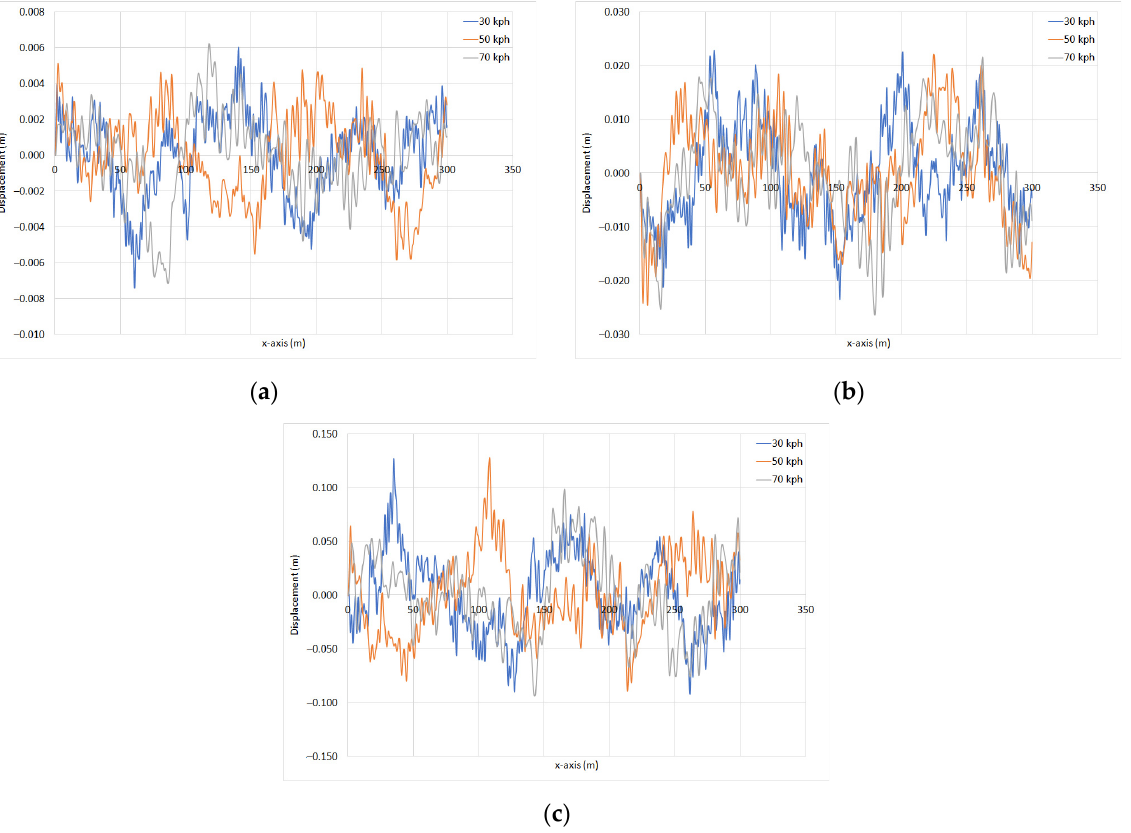
Figure 10. The vertical displacement of the sprung mass versus the position of the vehicle on the x-axis for road profiles of ( a ) Class A, ( b ) Class C and ( c ) Class E.